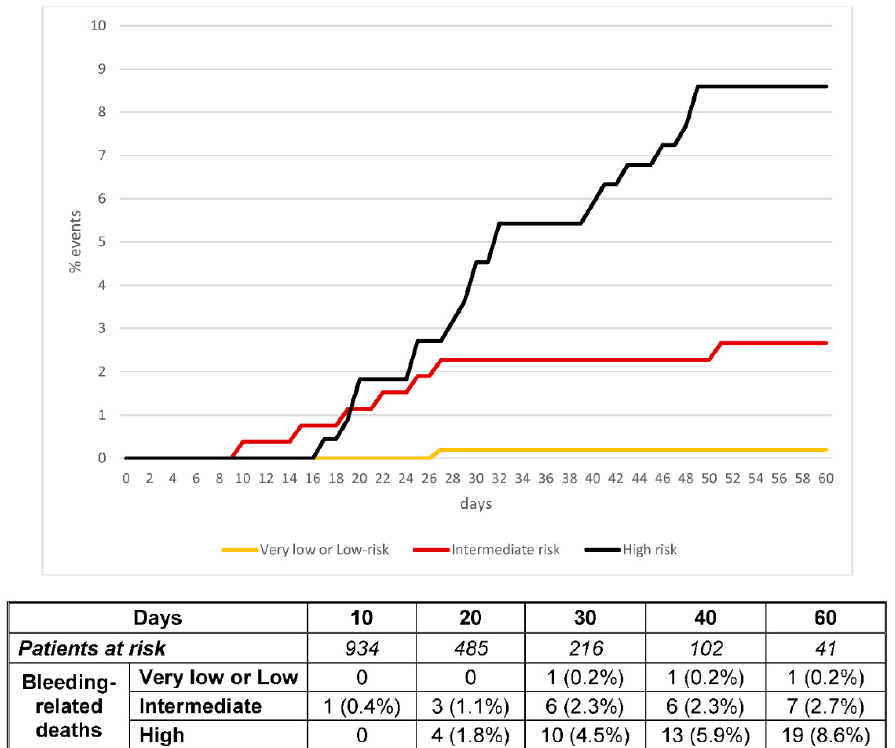
Figure 2. Cumulative incidence of bleeding-related death according to the prognostic score.